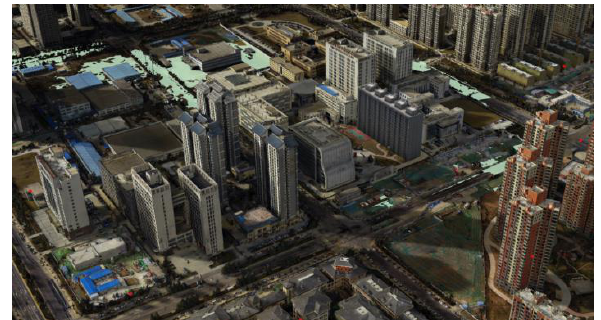
Figure 8. Rainstorm inundation scenario (simulate the scenario of heavy rain, the blue part is the flooded area)